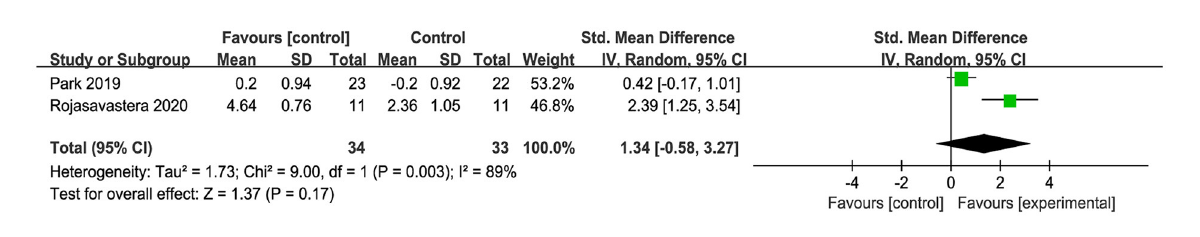
FIGURE8 Forest plot of the maintenance on global cognition in older adults with MCI compared with sham